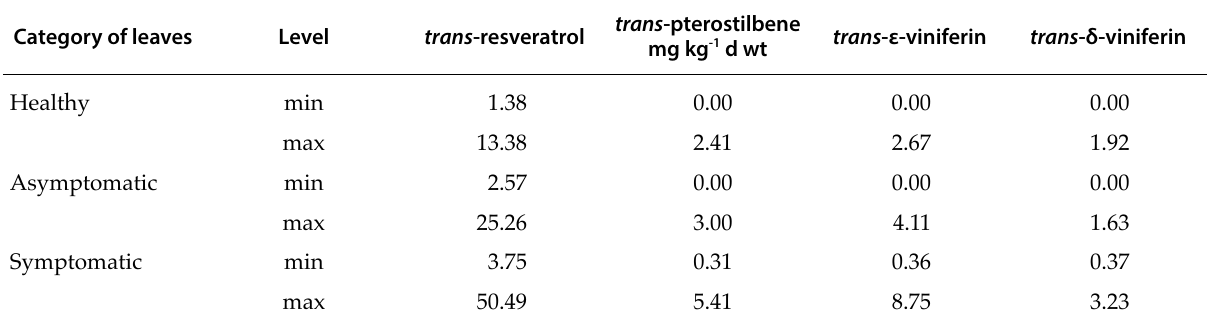
Table 3. Ranges of average concentrations of phytoalexins extracted from the leaves of different categories of grapevine plants growing in the Controguerra and Giulianova vineyards, during the growing seasons